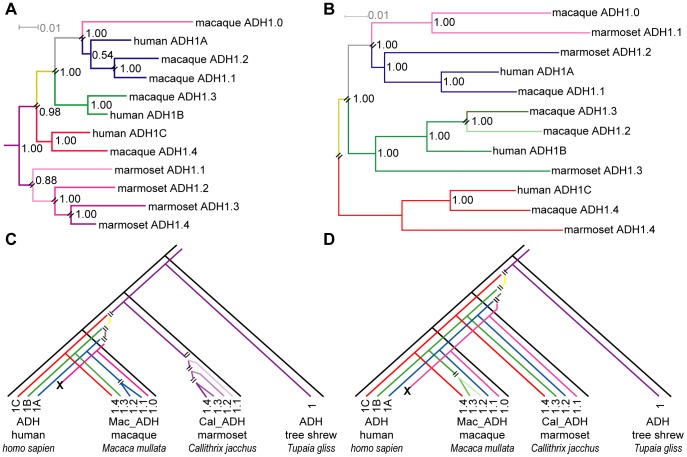
Phylogeny of primate ADH1 paralogs.Phylogeny of primate ADH1 paralogs inferred from (A) exonic sequence data (“exonic tree”) and (B) intronic data (“intronic tree”). Parallel black lines indicate bifurcations associated with gene duplications without speciation. ADH1 genes from New World monkeys (represented by marmoset) form a separate clade from the hominid/OWM genes in the exonic tree (A), while they interleave with hominid/OWM genes in the intronic tree (B). The lower panels, (C) and (D), redraw the gene tree from (A) and (B) in a species tree format, highlighting where each gene duplication occurs relative to the divergence of each primate lineage. The exonic tree is rooted using multiple non-primate ADH1 genes (see Figure S2). The intronic tree is unrooted (due to ambiguity, see text). The names of ADH1 paralogs have been shortened (e.g. the marmoset (Callthrix jacchus) ADH1 paralog “Cal_ADH1.1” is simply referred to as “marmoset ADH1.1”). Numbers at nodes refer to the Bayesian posterior probability values.